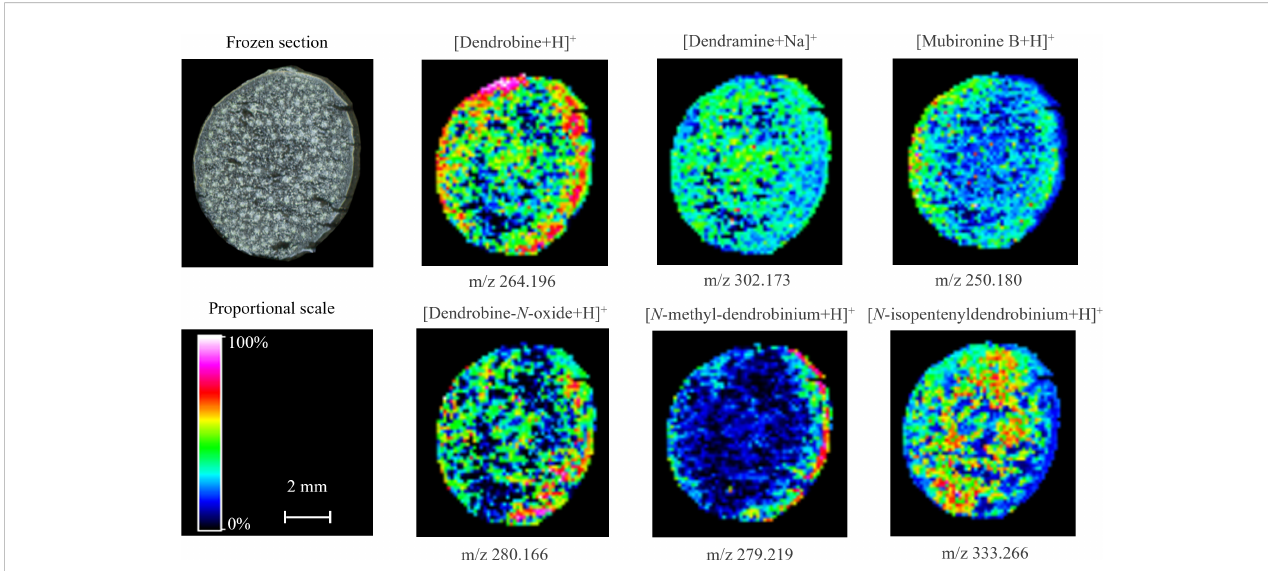
FIGURE 4 Distribution of dendrobine-type alkaloids in mature Dendrobium nobile stem imaged by MALDI-MSI. Heat maps were applied to present the relative distributions and